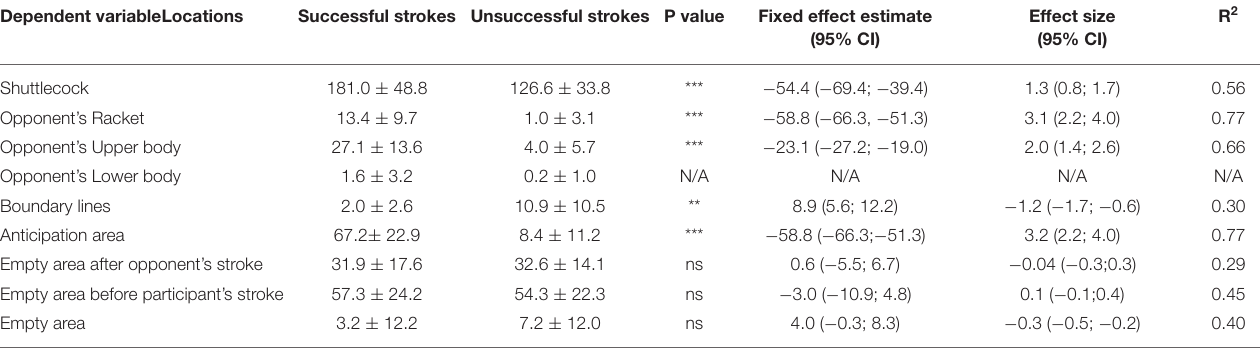
TABLE 2 | Number of fixations on each location for successful and unsuccessful strokes during rallies. Dependent